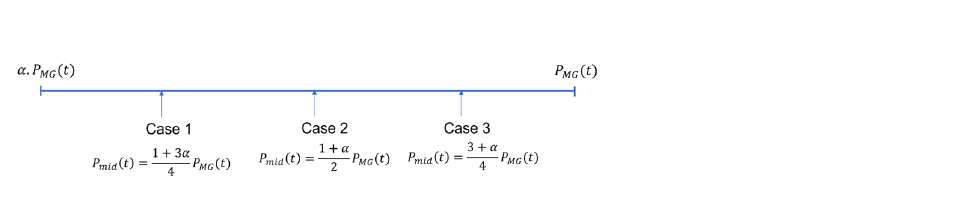
Figure 10. Energy cost of each home in community with three CEMSs.